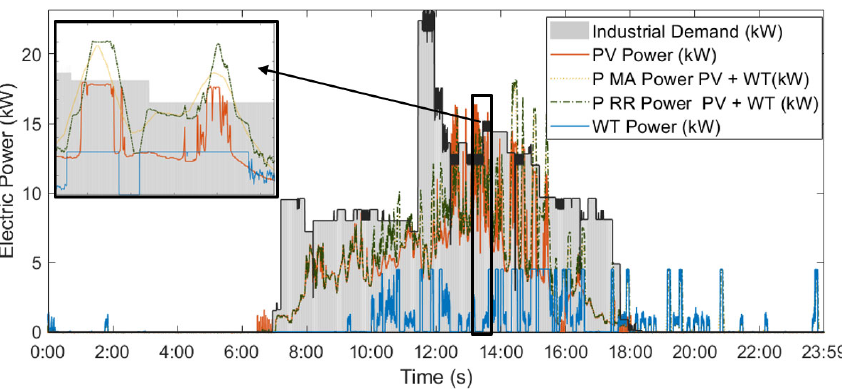
Figure 10. Control algorithm result, power smoothing methods for a system (PV + WT + SC).